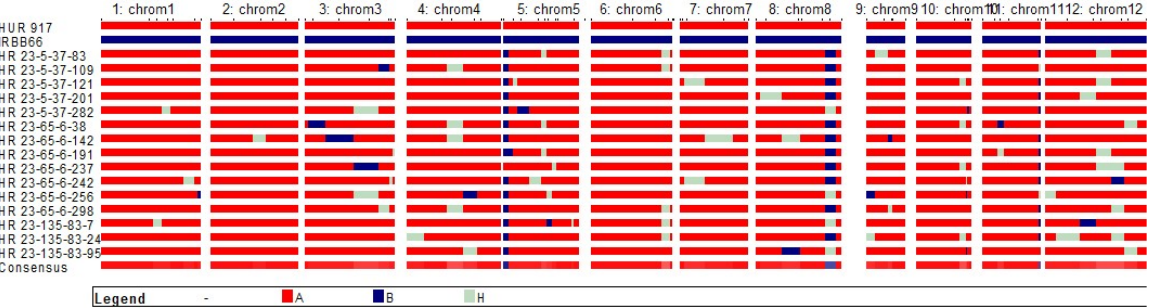
Figure 4. Extent of BB resistance in parents and derivative NILs (BC 2 F 3 ) inoculated with 8 virulent Xoo isolates after 21 days of inoculation.